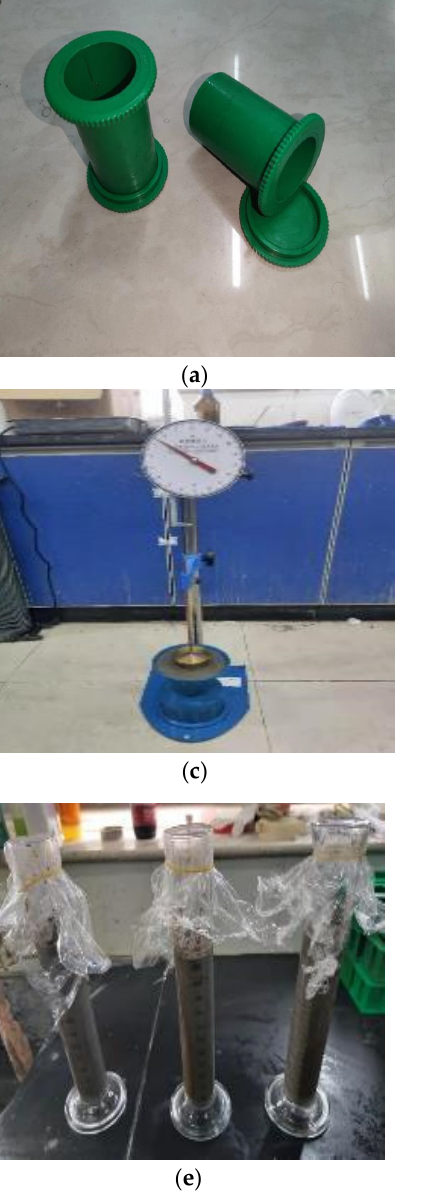
Figure 2. Profiles of the different physical characterizations. ( a ) Mold for specimen; ( b ) slurry density test; ( c ) consistency test; ( d ) fluidity test; ( e ) bleeding rate and consolidation shrinkage rate test; ( f ) setting time test.